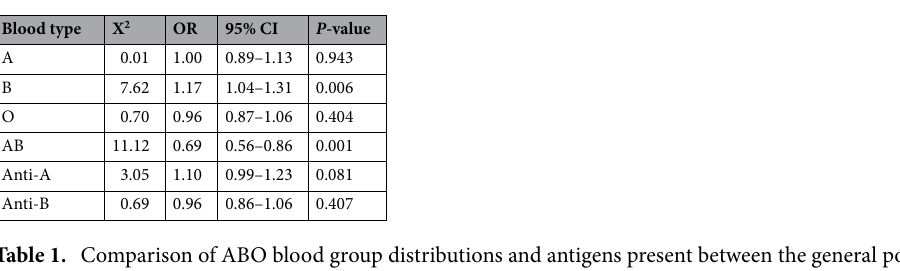
Table 1. Comparison of ABO blood group distributions and antigens present between the general population and COVID-infected sample.